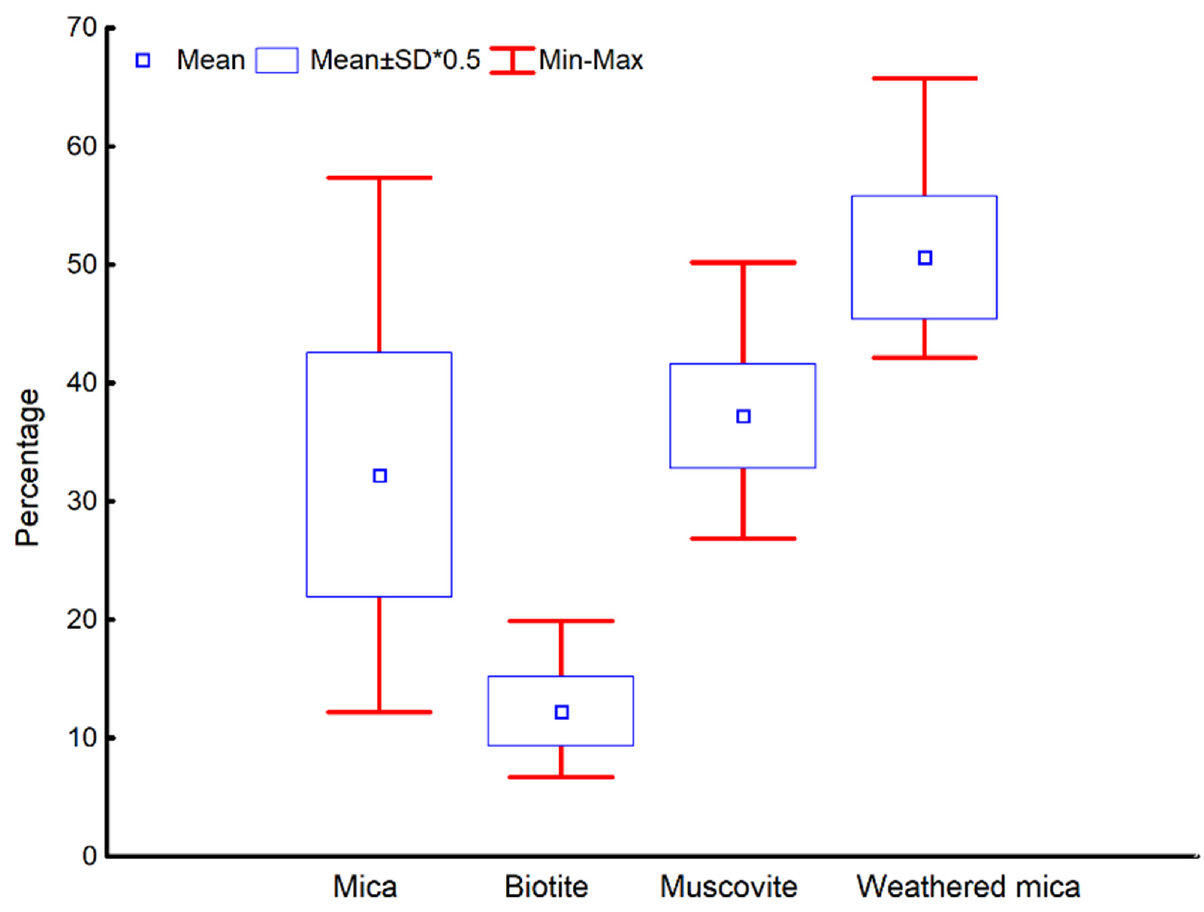
Figure 3. Mass percentage of mica, particle percentages of biotite, weathered mica and muscovite in the very fine sand fraction of the collected Yangtze River Estuary sediment samples (mass percentage of mica = 100 * total mica mass/total mineral mass. Particle percentage of biotite or weathered mica or muscovite = 100 * particle number of biotite or weathered mica or muscovite/total particle number of mica).